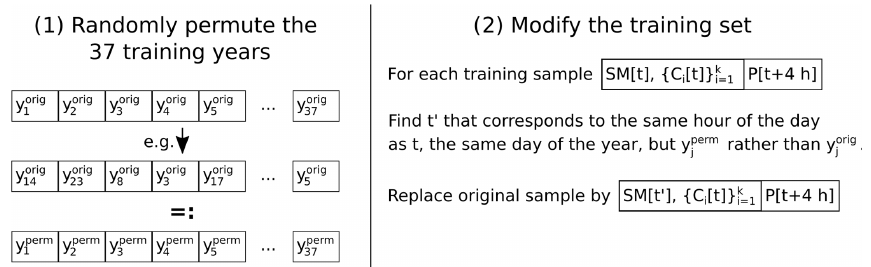
Figure 8. Modification of the training data for the year-wise permutation of SM [ t ] . The modification of the test data works